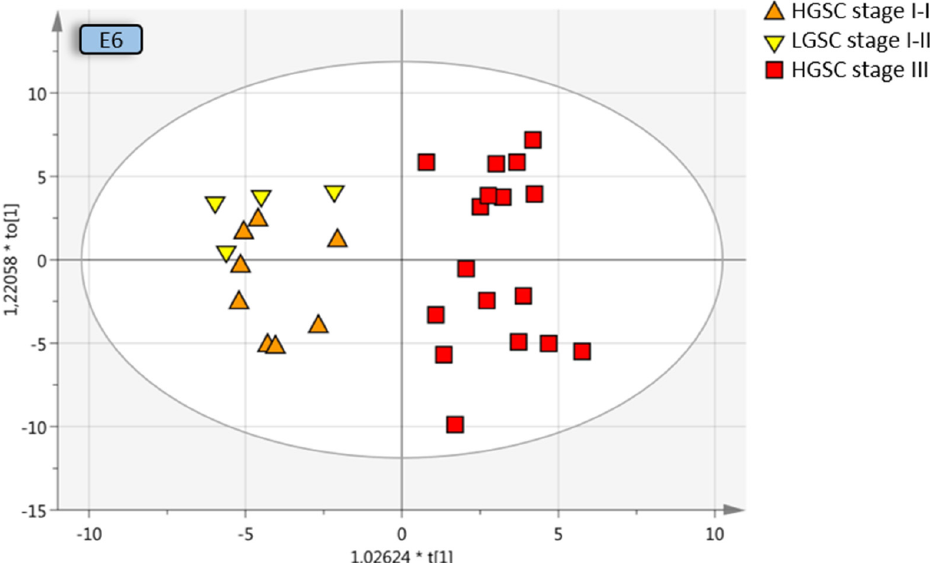
Figure 4. Multivariate OPLS-DA model where LGSC and HGSC stage I–II are grouped and compared to HGSC stage III, resulting in a predictive value of 0.612 (model E6, Table 3). Coloring has been done according to subgroup and not the OPLS-DA classes for visualization purposes. OPLS-DA = orthogonal projection to latent structures-discriminant analysis, LGSC = low-grade serous cancer, HGSC = high-grade serous cancer.